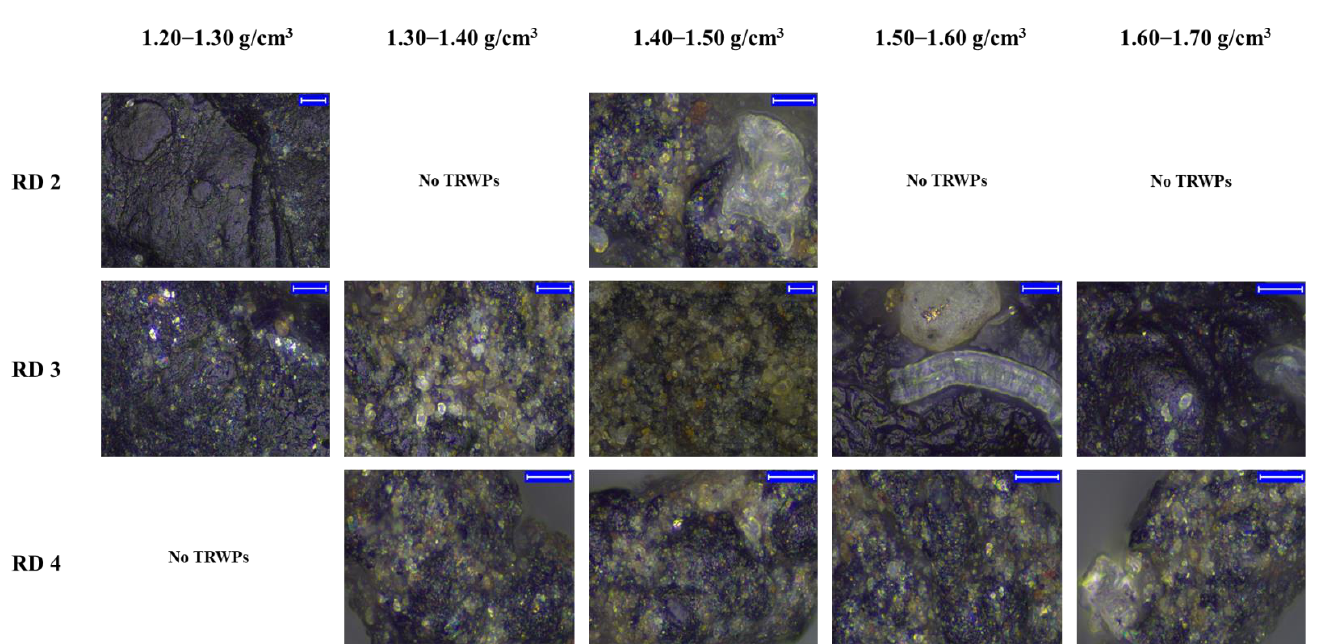
Figure 8. Magnified images of the TRWPs classified from the road samples. The blue scale bar is 100 µm.